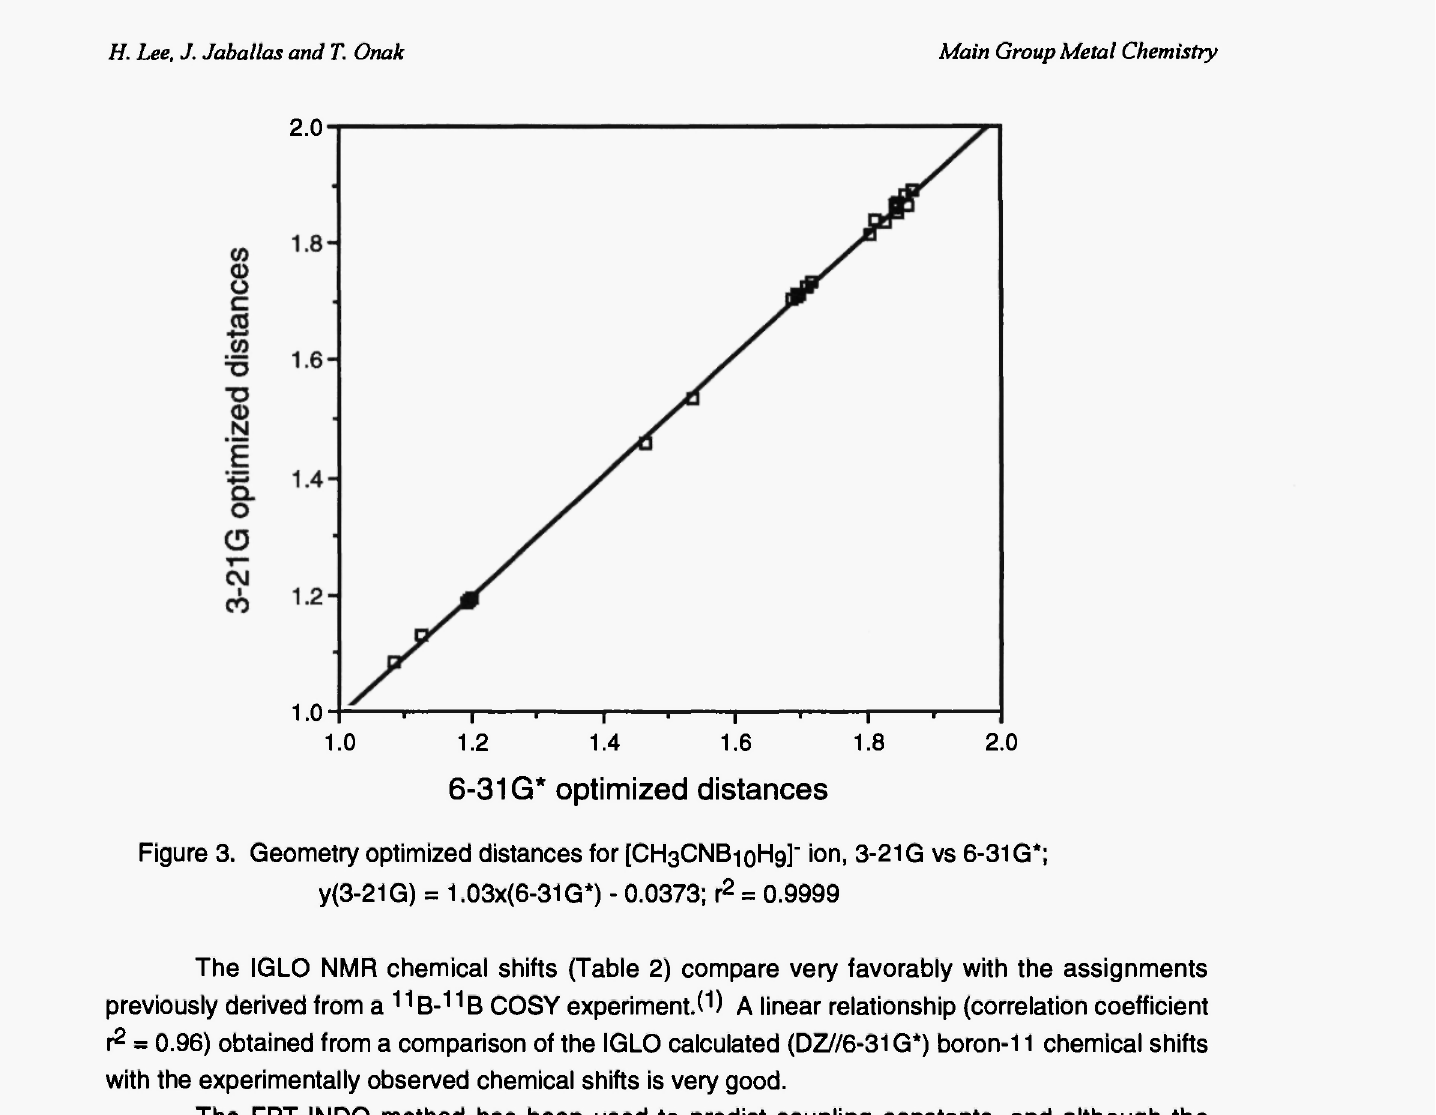
Figure 3. Geometry optimized distances for [CH3CNB10H9]" ion, 3-21G vs 6-31G*; y(3-21G) = 1.03x(6-31G*) - 0.0373; r 2 =